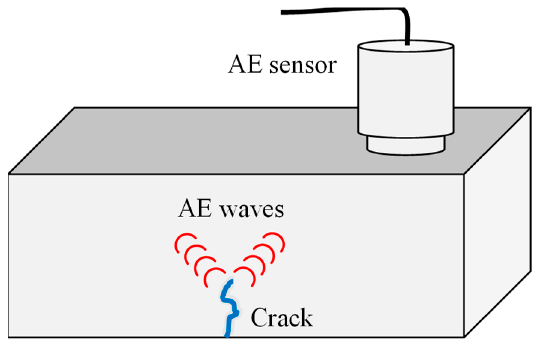
Figure 23. Principle AE measurement. Figure 24. Principle AE